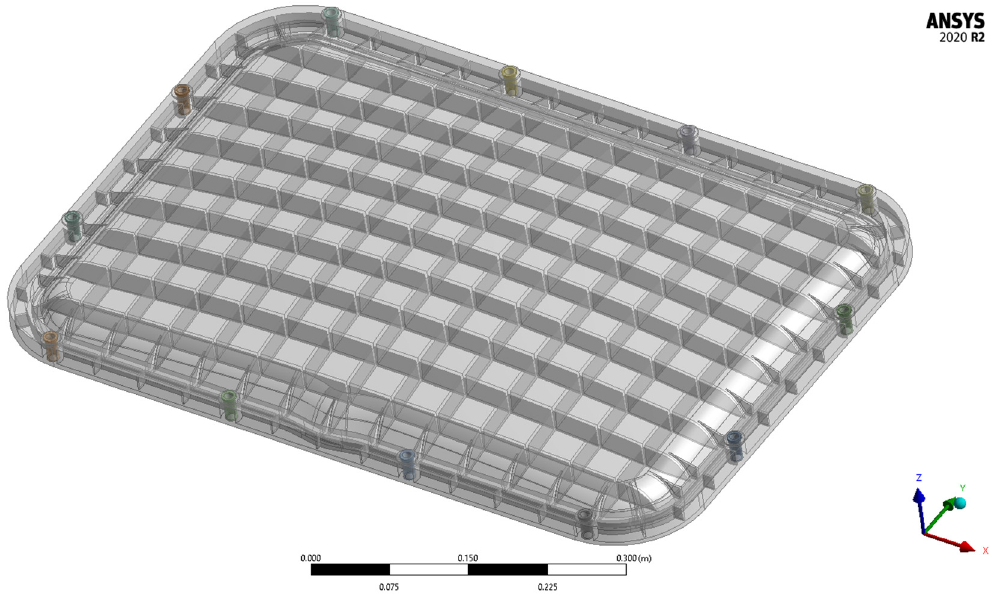
Figure 2. Redesigned camshaft cover in 30% wt GFs/PA6,6.